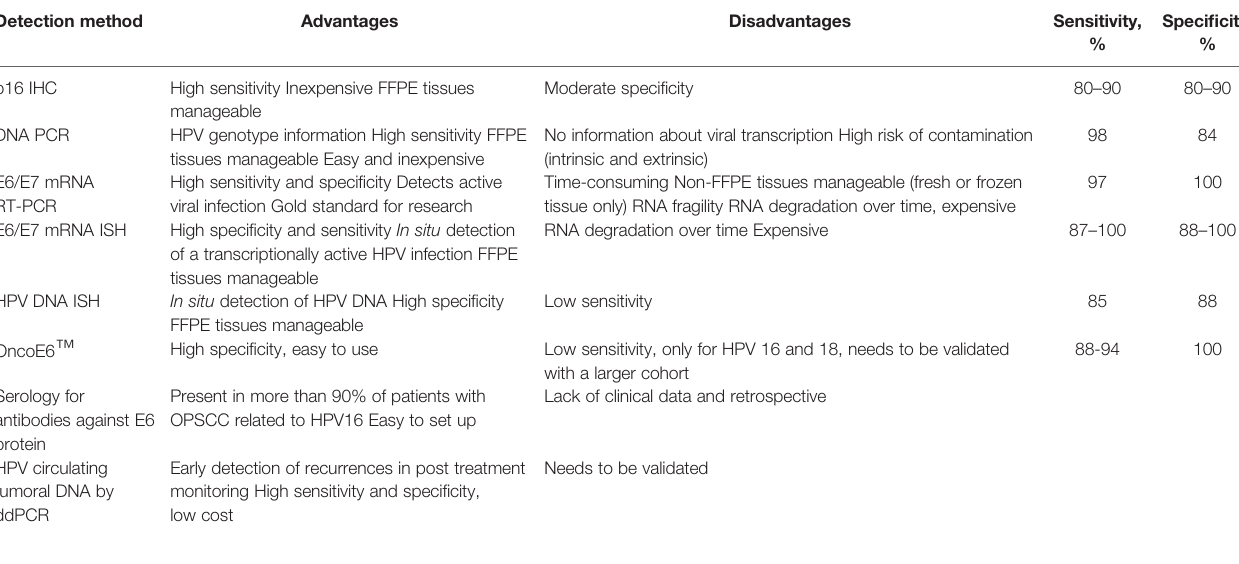
TABLE 9 | Summary of HPV detection techniques used in